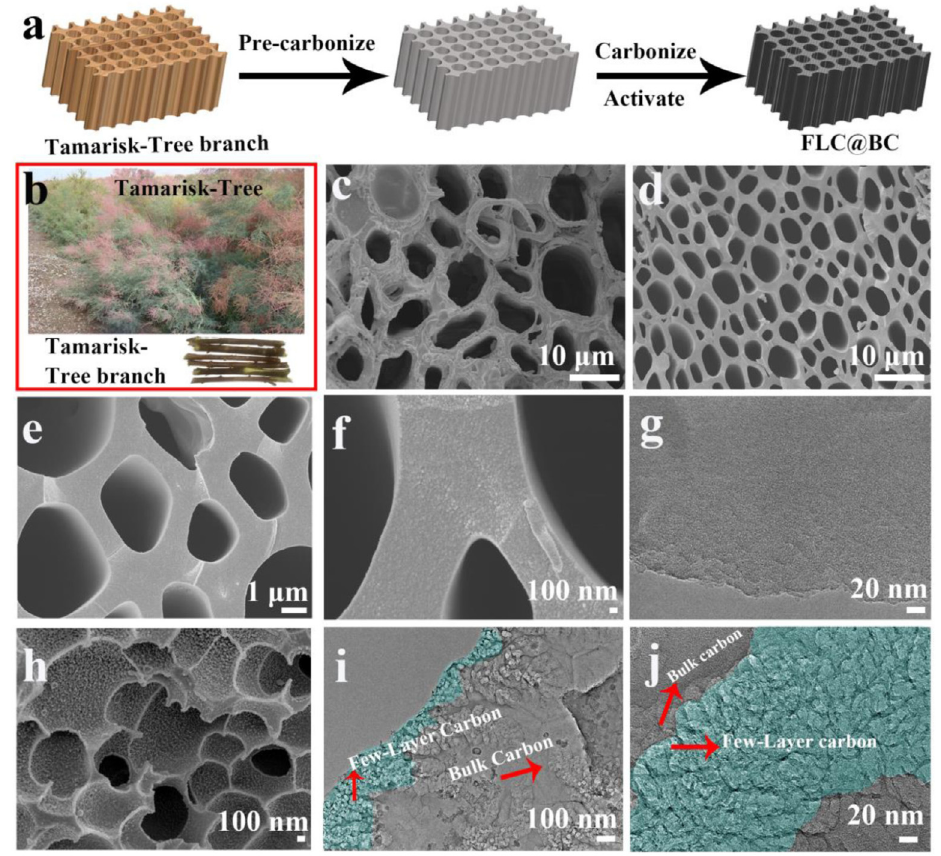
Figure 1. Schematic and images showing ( a ) the tamarisk tree branches under pre-carbonization, carbonization, and activation treatment procedures; ( b ) tamarisk tree and branches under visible light; ( c ) the tamarisk tree branch under scanning electron microscope (SEM); ( d – f ) carbonized sample without KOH activation under SEM; ( g ) carbonized sample without KOH activation under transmission electron microscope (TEM); ( h ) carbonized sample with KOH activation under SEM; ( i , j ) carbonized sample with KOH activation under TEM. Reproduced with permission from [4], ©2020 Elsevier Ltd.